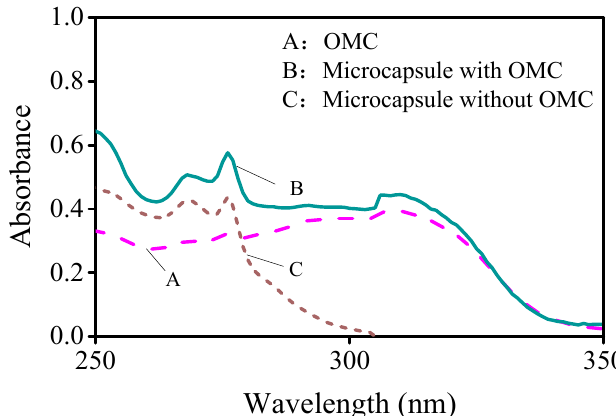
Figure 11. Ultraviolet absorption effect of the OMC, OMC microcapsule, and microcapsule with- out OMC.